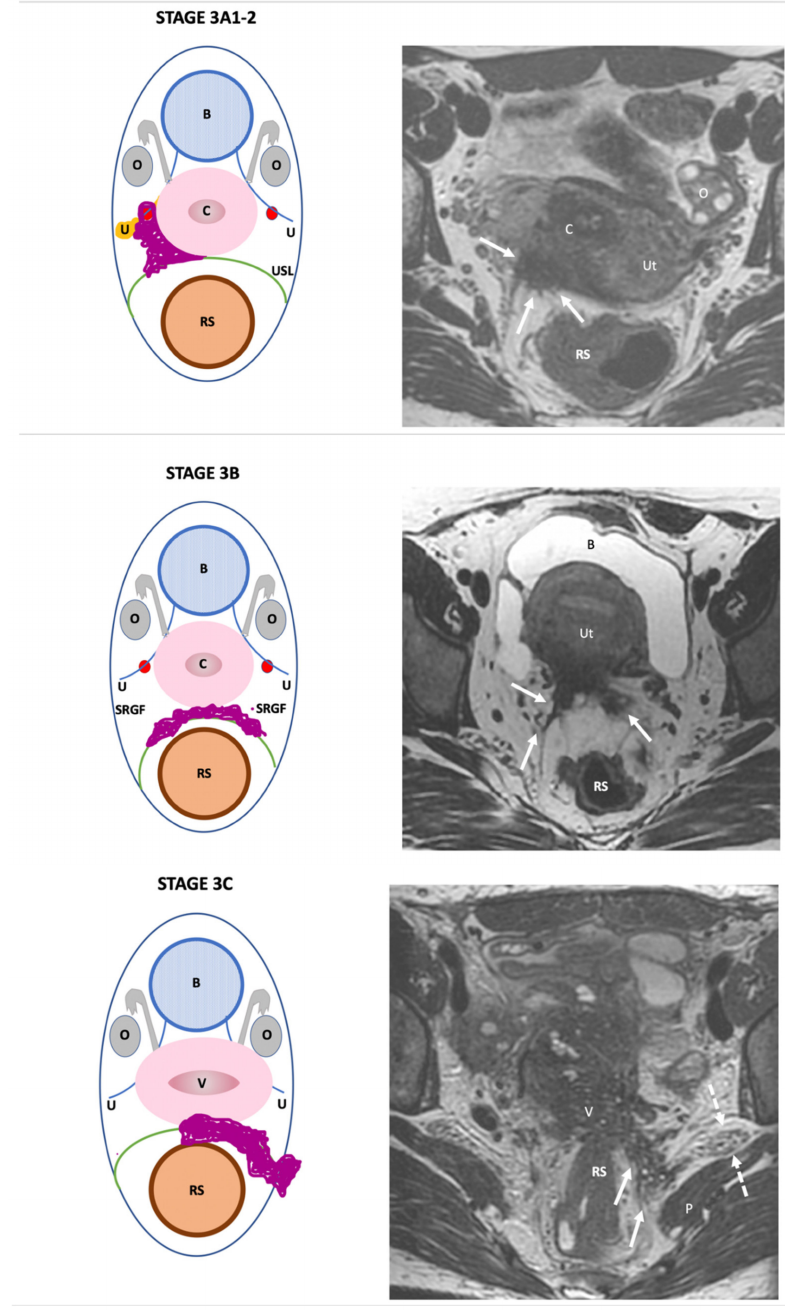
Figure 4. Schematic and example of stage IIIA1 Endo-Stage MRI classification showing the presence of a large irregular mass with low signal intensity on a T2-weighted MRI involving right uterosacral ligament and parametrium (arrows). Schematic and example (of stage IIIB Endo-Stage MRI clas- sification showing the presence of bilateral involvement of sacro-recto-genital fascia that appears irregular and thickened with low signal intensity on a T2-weighted MRI (arrows). Schematic and example of stage IIIC Endo-Stage MRI classification showing the presence of extensive deep posterior and lateral deep endometriosis displaying low signal intensity on a T2-weighted MRI and multiple tiny high signal intensity spots. This lesion involves the vagina ( V ), rectosigmoid colon ( RS ), right sacro-recto-genital fascia and lateral pelvic wall abutting close to piriformis ( P ) and sciatic nerve (dotted arrows). Note: ( B ): bladder, ( C ): cervix, ( RS ): rectosigmoid colon, ( O ): ovary, ( U ): ureter, ( USL ): uterosacral ligament, ( Ut ): uterus; red point: uterine artery, ( SRGF ): sacro-recto-genital